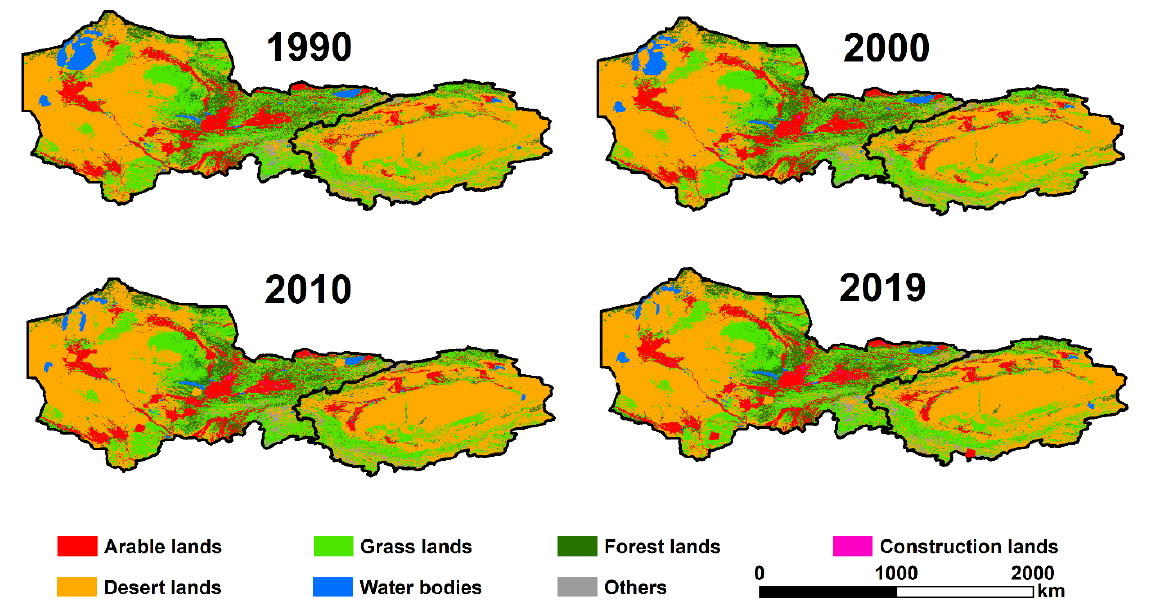
Figure 3. Land use change in the Aral Sea Basin and the Tarim River Basin, Central Asia, before and after EWC.